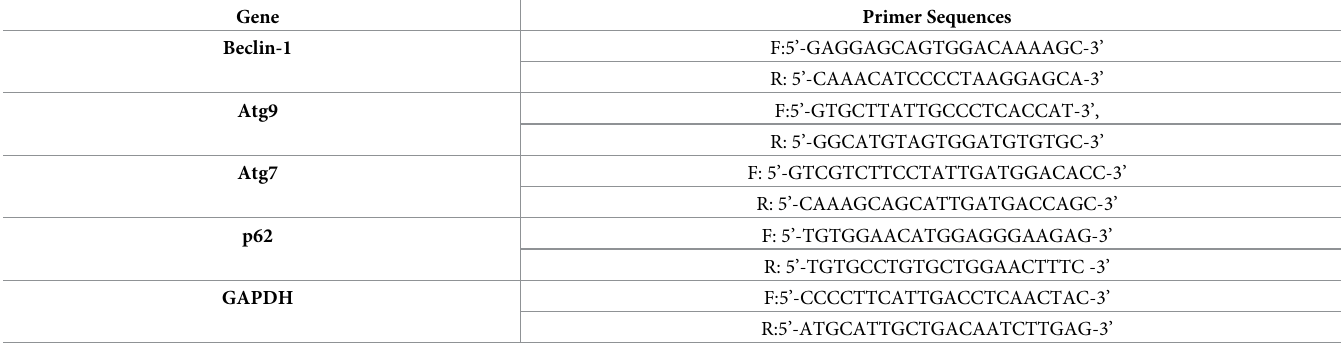
Table 1. Primers that are used in